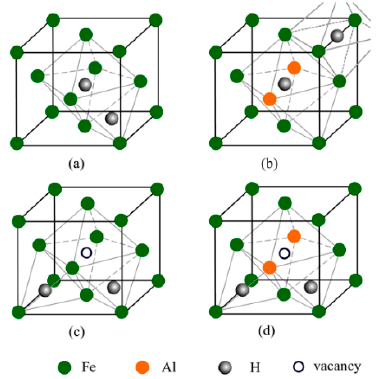
Figure 2. The atomic structures of the most stable interstitial compounds of Al-free and Al-containing austenites including two hydrogen atoms in NM state ( a , b ) and FM state ( c , d ).